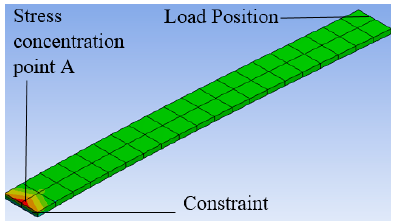
Figure 4. The finite element model of the flat spring.